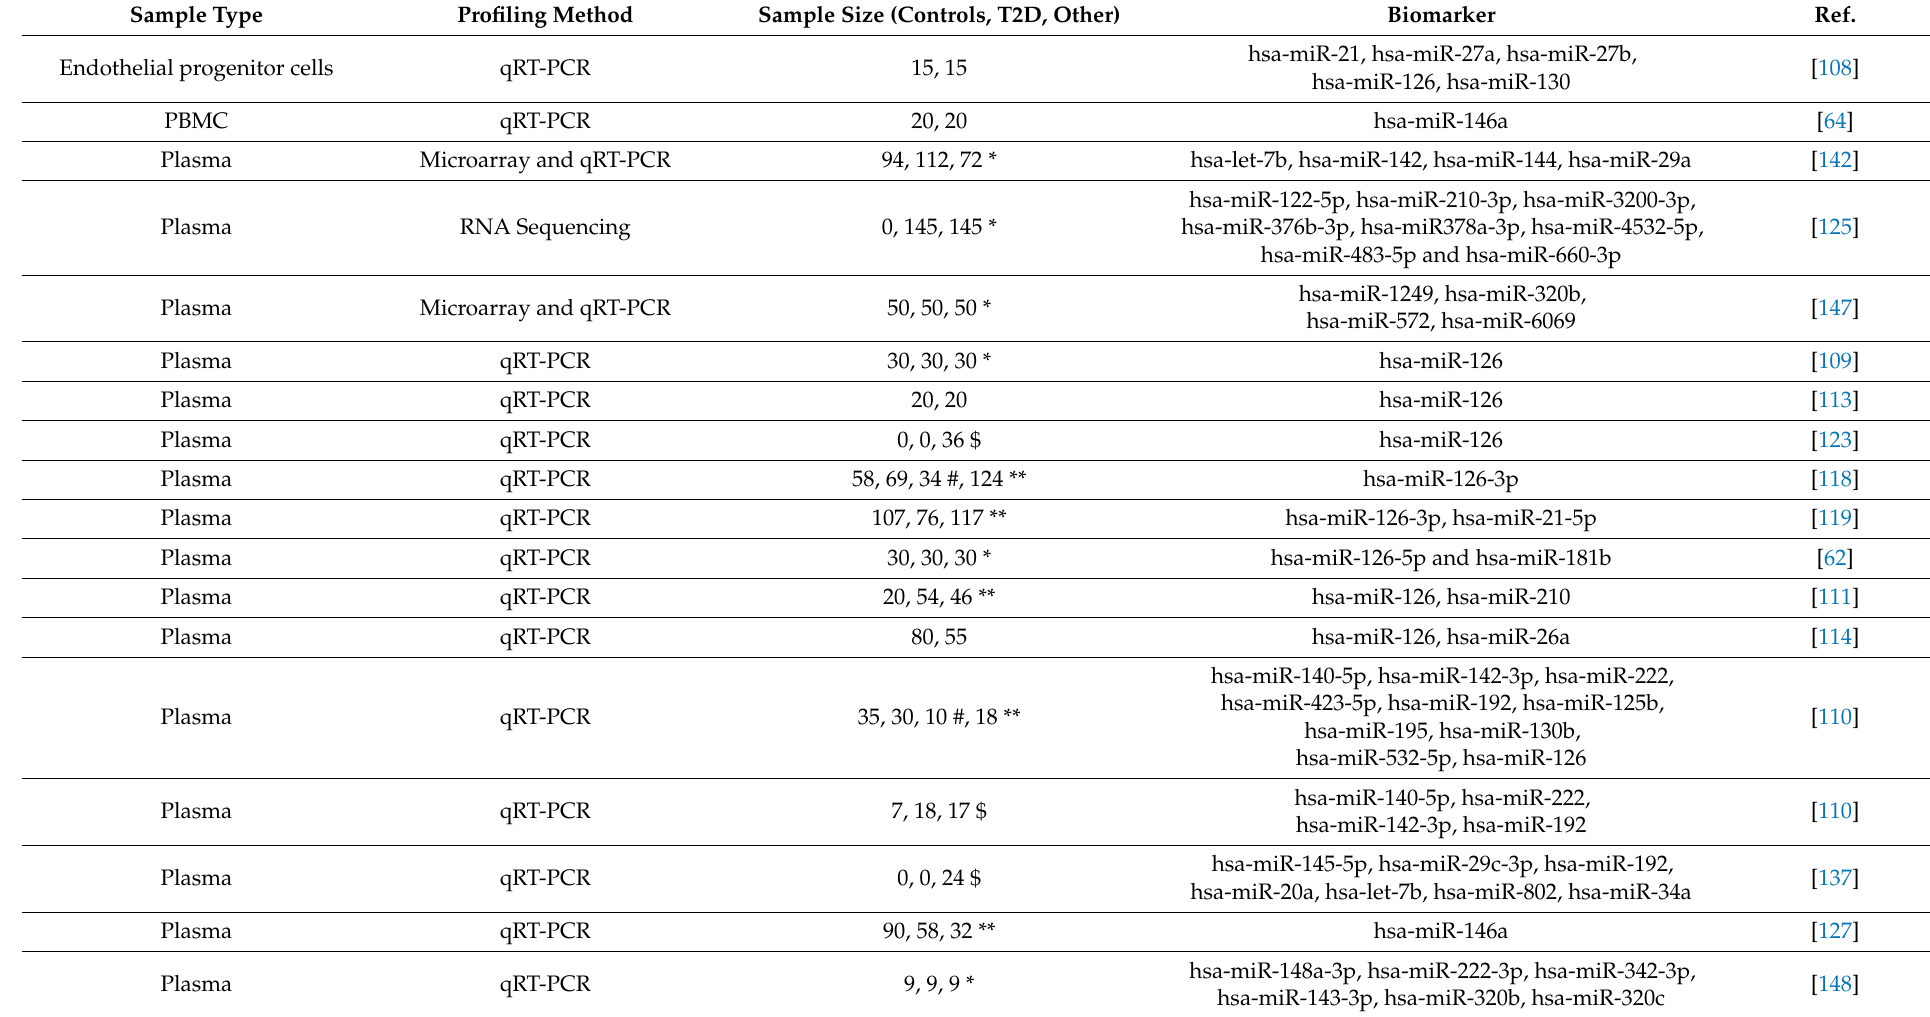
Table 8. microRNA biomarkers from blood samples for